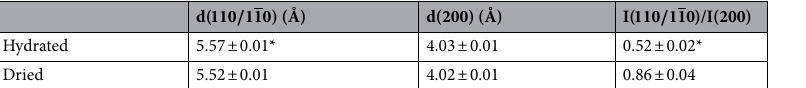
Table 1. Cellulose lattice spacings of the ( 110 / 110 ) and (200) planes and the ratio of the peak intensity at ( 110 / 110 ) to that of (200) from the out-of-plane GIWAXS profiles of hydrated and dried onion epidermal wall. Values shown are the sample mean ± standard deviation, where n = 3. p-values obtained by comparing hydrated and dried using a paired student’s t-test. *p < 0.05 for comparison between hydrated and dried samples.